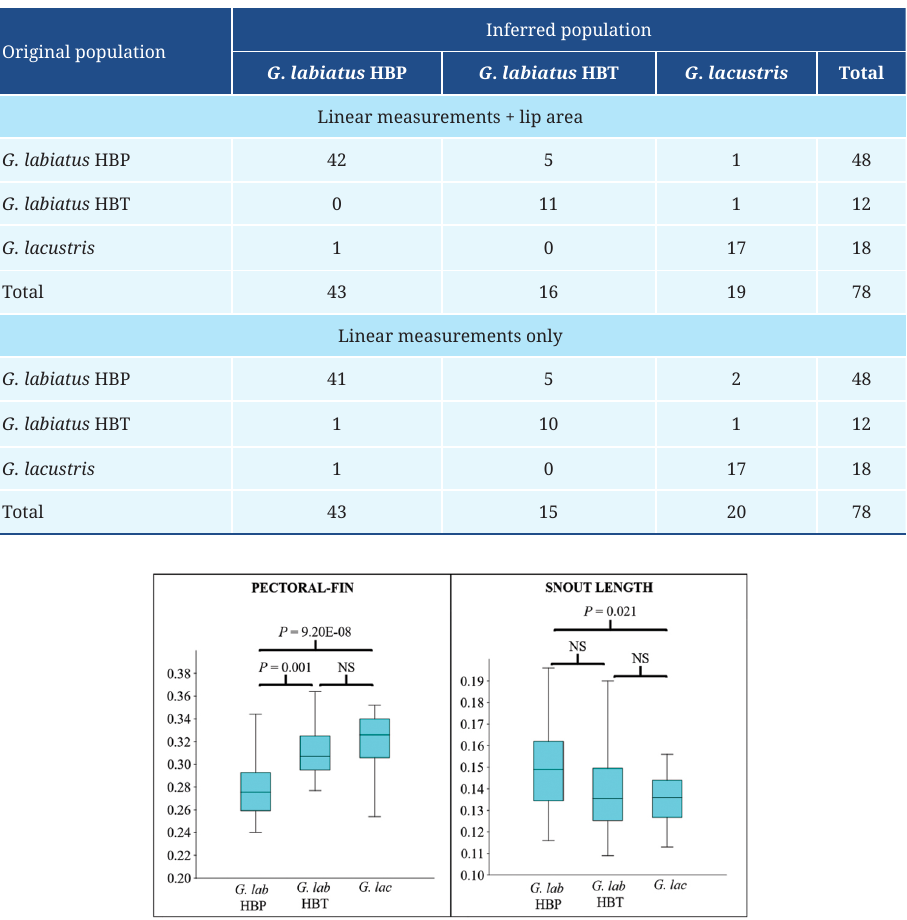
TABLE 5 | Confusion matrix for the CVA of morphological data of Gymnogeophagus